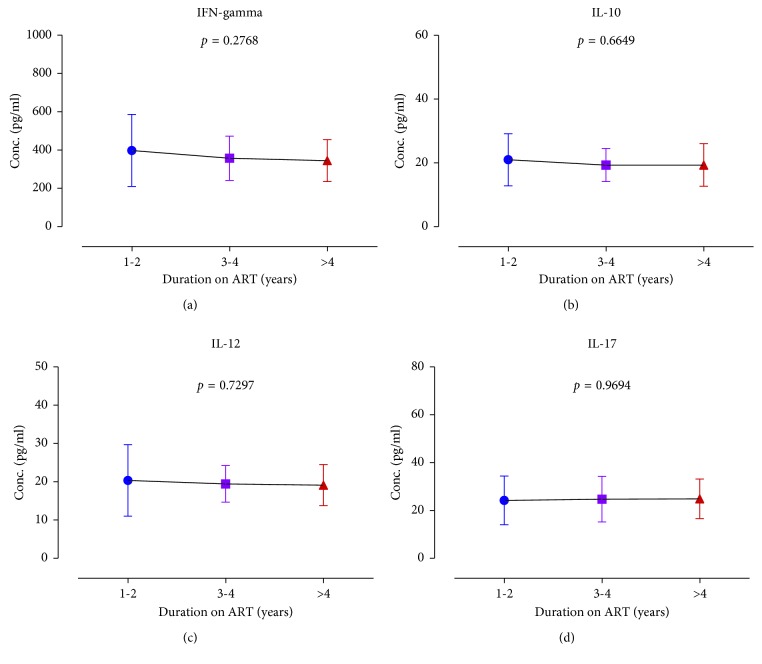
Cytokine distribution of the study participants according to their duration on ART: (a) IFN-gamma, (b) IL-10, (c) IL-12, and (d) IL-17.